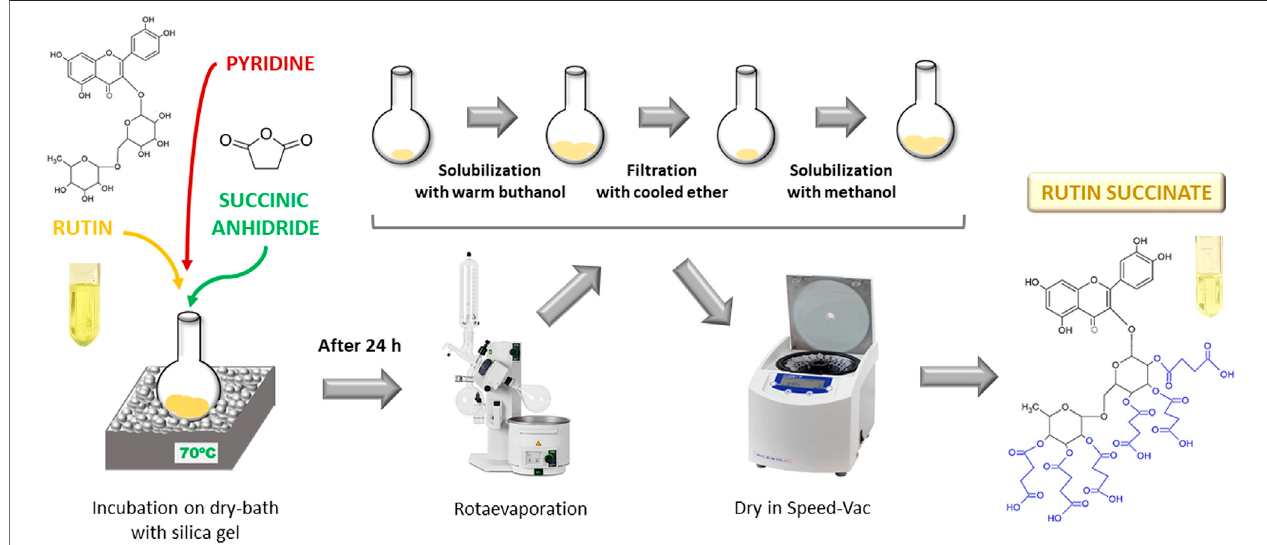
FIGURE 1 | Schematic representation of rutin succinate